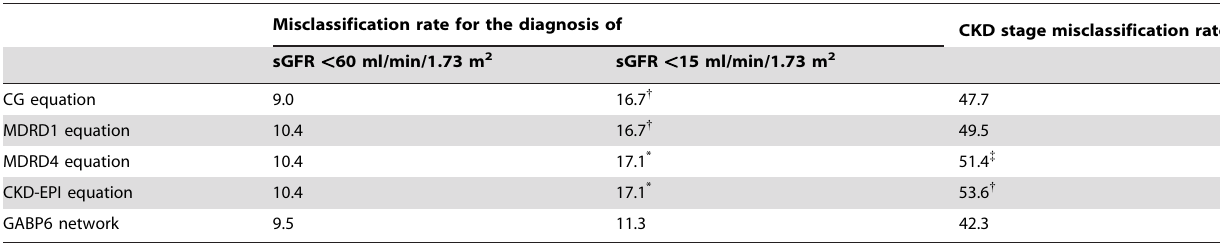
Misclassification rate for the diagnosis